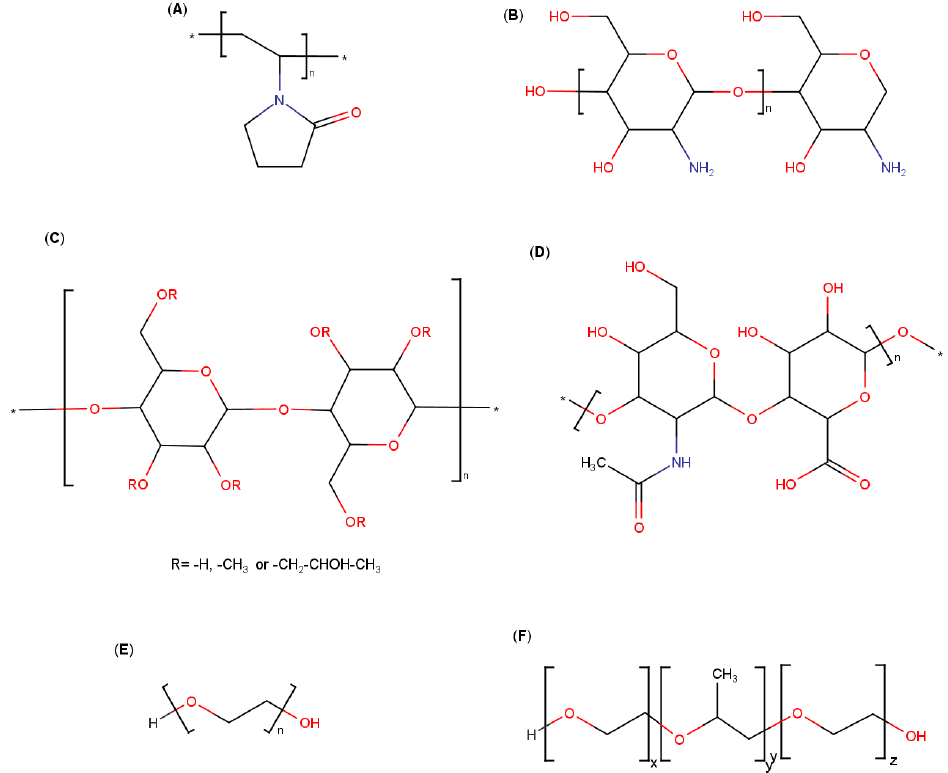
Figure 7. Molecular structures of ( A ) PVP-K30, ( B ) chitosan, ( C ) hydroxypropylmethylcellulose, ( D ) hyaluronic acid, ( E ) polyethylene glycol and ( F ) poloxamer. PVP-K30 was also used in a multicomponent complex with βCD and cefuroxime axetil, to improve the latter’s pharmaceutical characteristics, via the kneading method [77]. Cefuroxime axetil is a prodrug of cefuroxime cephalosporin, which is used for pharyngitis, respiratory tract infections, acute bacterial otitis, simple skin infections and urinary tract infections. It is a BCS class II drug, so it has less aqueous solubility with an oral bioavailability of 37% on an empty stomach, which increases to 52% if taken after meals. In this multicomponent complex of cefuroxime axetil with βCD, PVP-K30 can act as a ternary component to improve its pharmaceutical characteristics. The